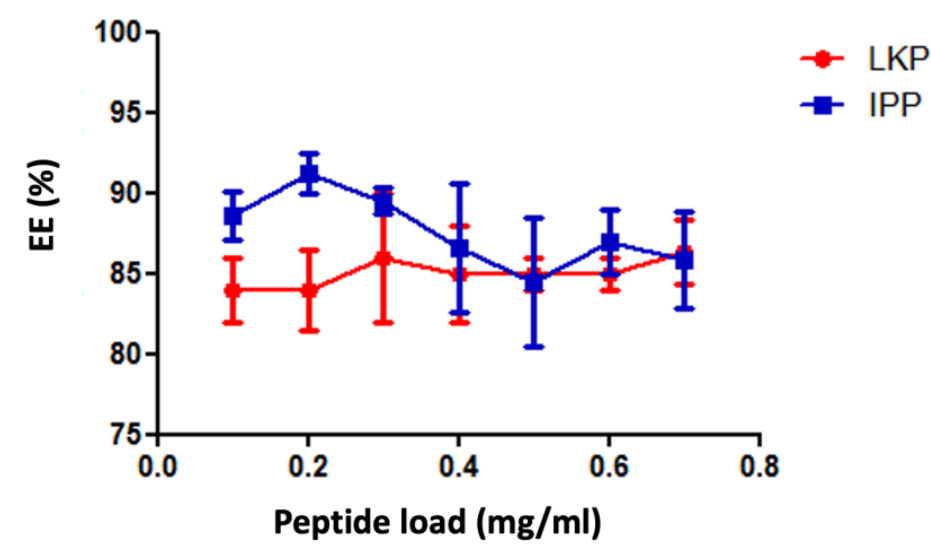
Figure 2: Changes in EE% for CZ NPs loaded at different concentrations of IPP and Figure 2. Changes in EE% for CZ NP loaded at different concentrations of IPP and LKP. Data are expressed as a mean ± SD of n = 3 batches. LKP. Data are expressed as a mean ±SD of n = 3 batches.